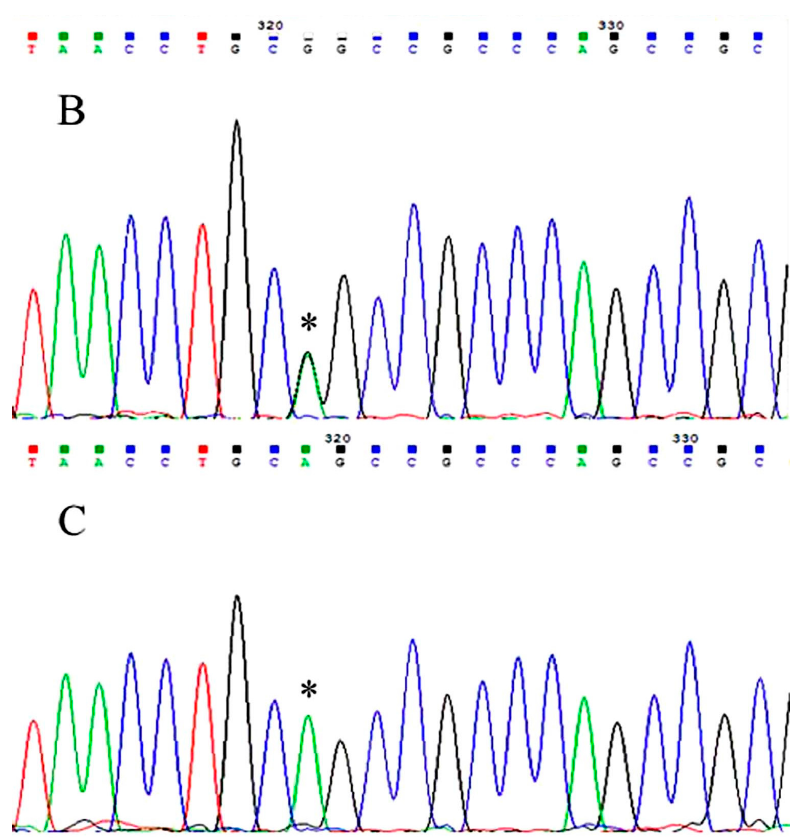
Figure 1. Gene sequence assay indicating LOX G473A polymorphism. GG, the homozygous GG genotype; GA, the heterozygous GA genotype; AA, the homozygous AA genotype. Three genotypes: GG, a black wave in ( A ); GA, a short black wave overlaid with a shorter green wave in ( B ); and AA, a green wave in ( C ) are marked by *.